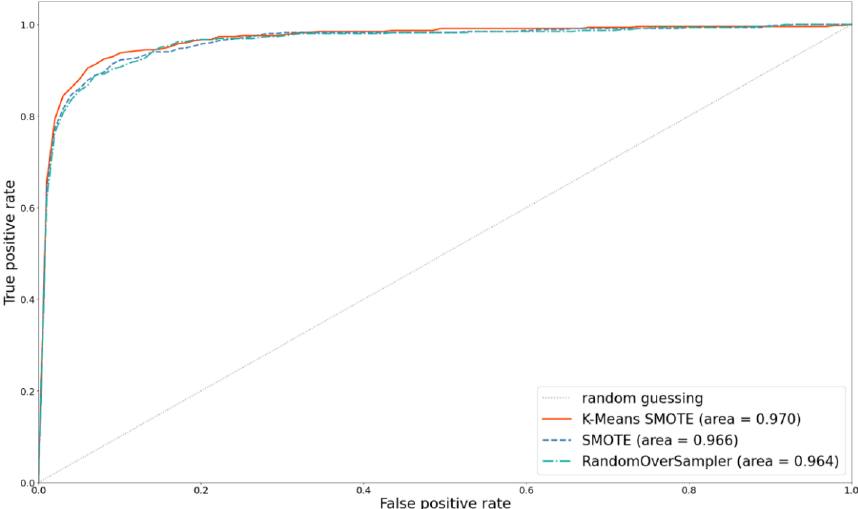
Figure 10. ROC curves comparison with different oversampling techniques.